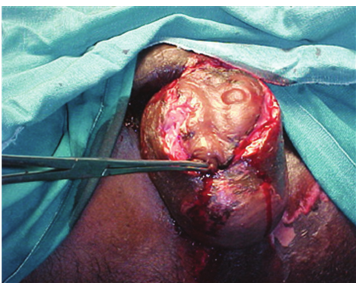
Figure 3: 8th postop day.